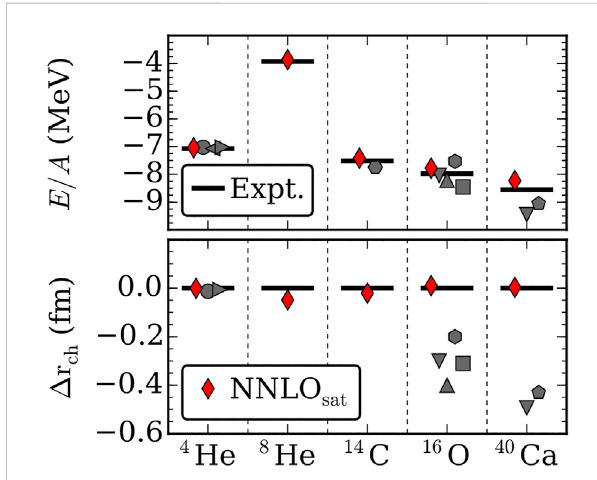
FIGURE 3 Ground-state energy (negative of binding energy) per nucleon (top), and residuals (differences between computed and experimental values) of charge radii (bottom) for selected nuclei computed with chiral interactions. In most cases, theory predicts too-small radii and too-large binding energies. Figure from Ref. [123], where additional details can be found.